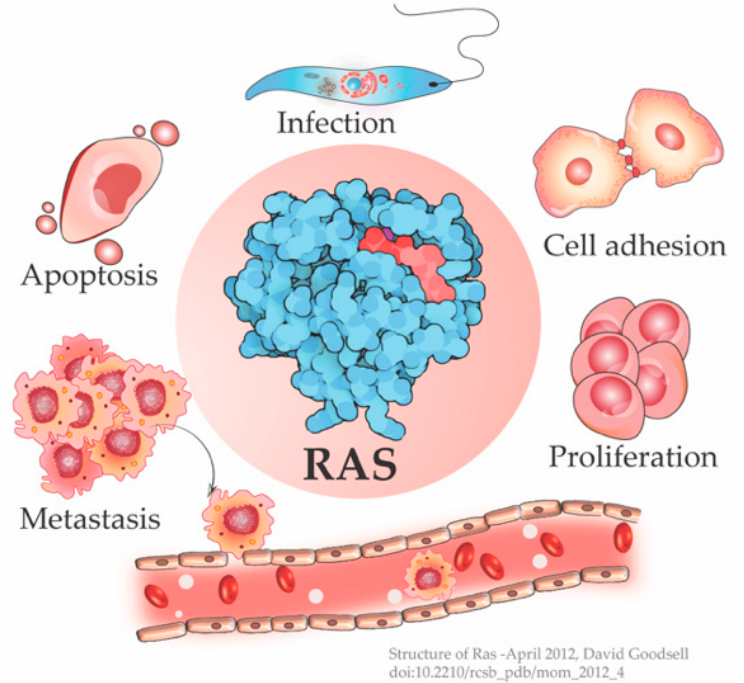
Figure 1. Ras is a signaling switch that regulates counteracting cellular functions like cell proliferation and apoptosis. Emerging studies have elucidated new functions of Ras e.g., in cytoskeletal rearrangement regulating cell adhesion and in parasitic infections like Leishmania , in addition to its well-known role in cancer progression. (Structure of Ras-April 2012, David Goodsell [5]).